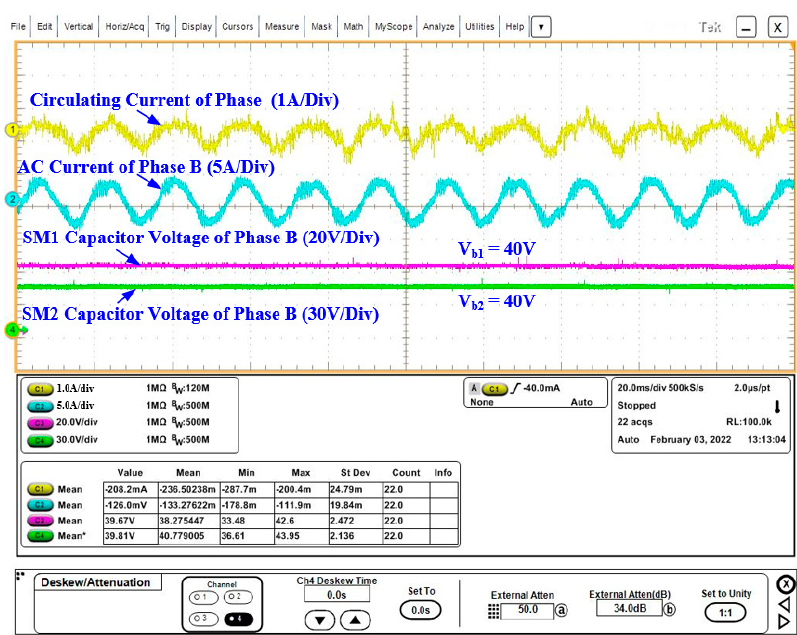
Figure 17. Parameters of phase B under steady state.